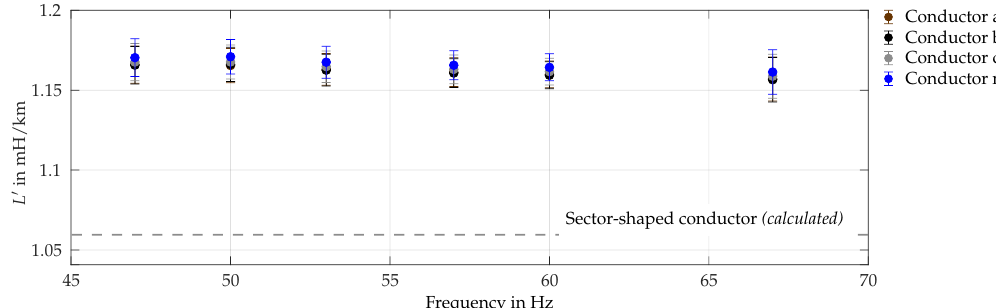
Figure 16. Measured self inductances (NAYY-J 4 × 150 SE, cable A ).